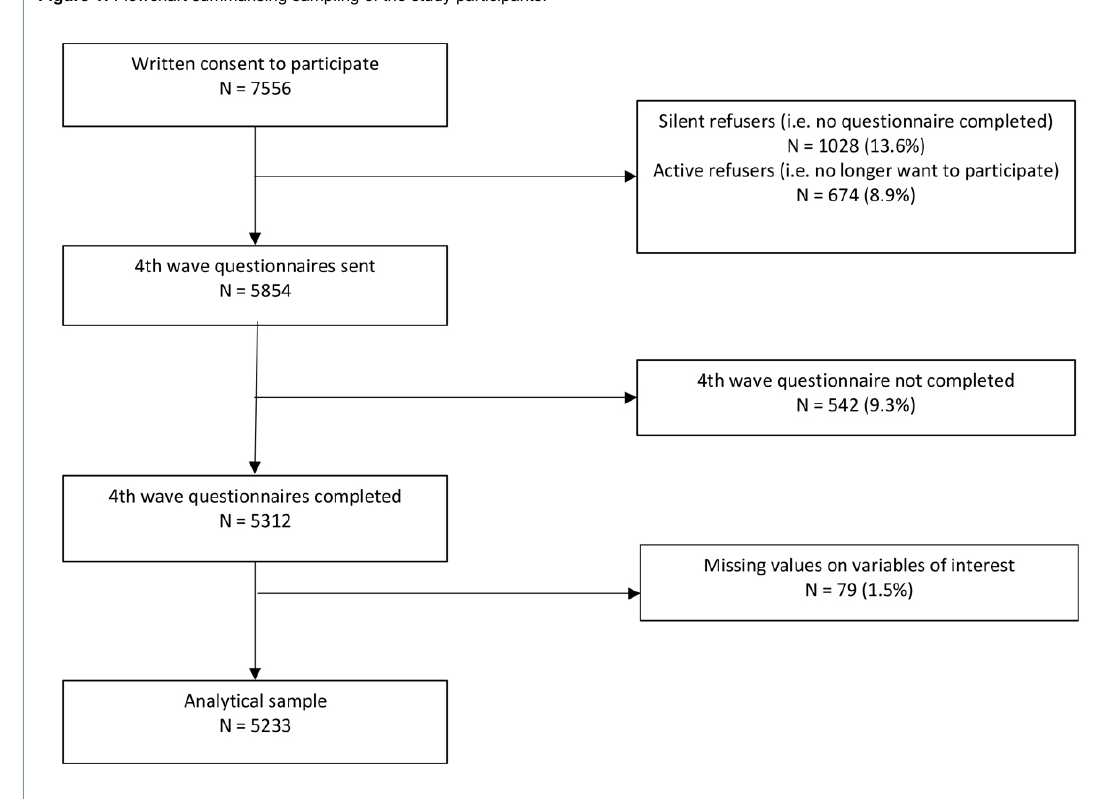
Figure 1: Flowchart summarising sampling of the study